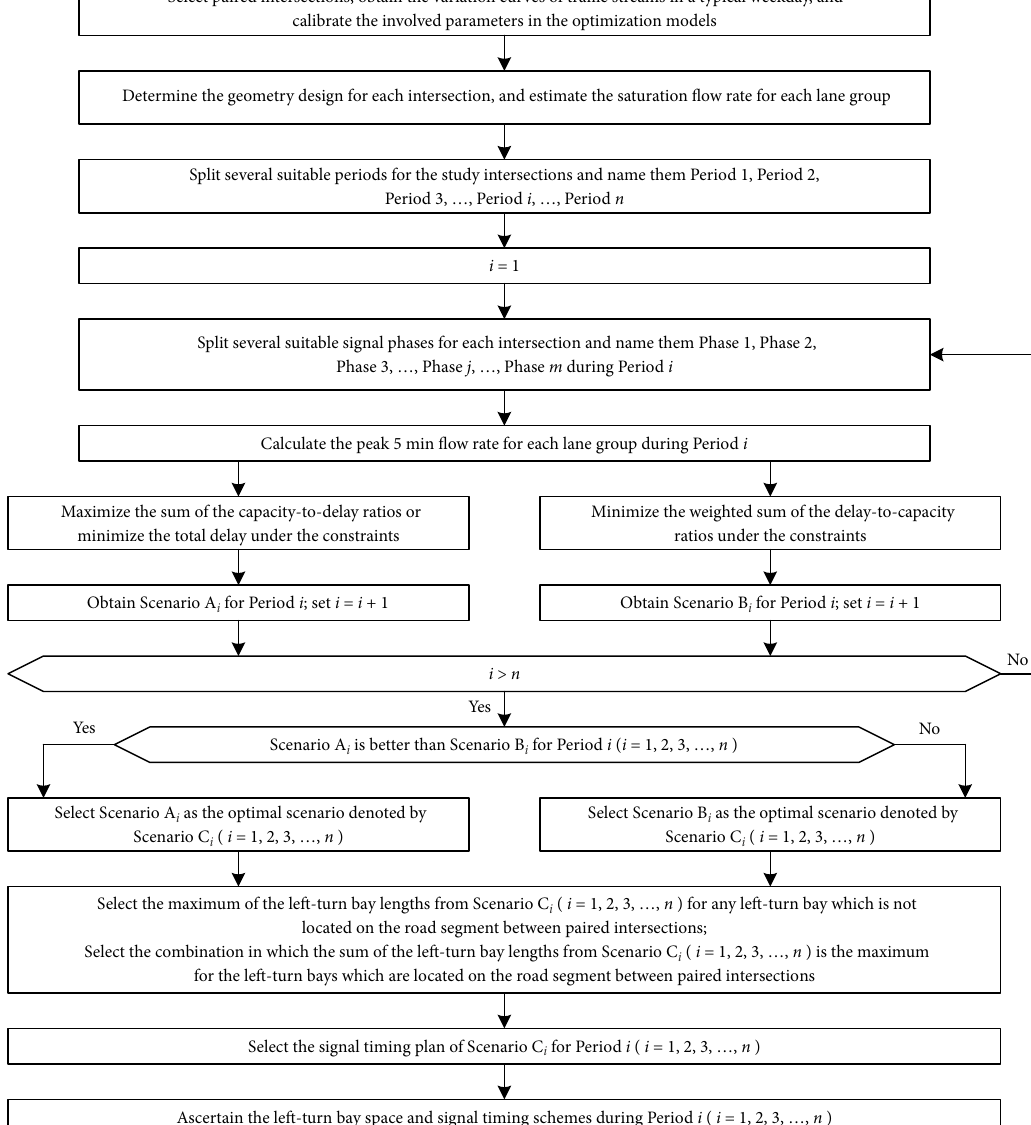
Figure 9. Flow chart of model